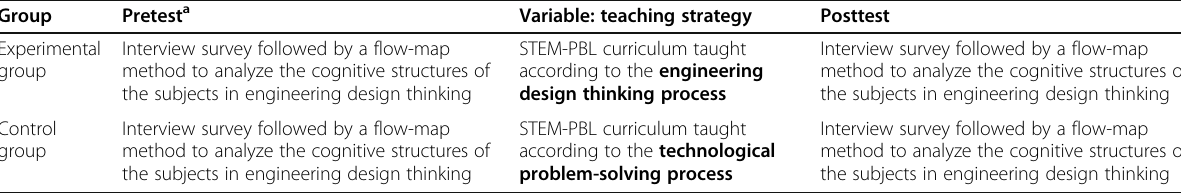
Table 1 Experimental design of the study Group Pretest a Variable: teaching strategy